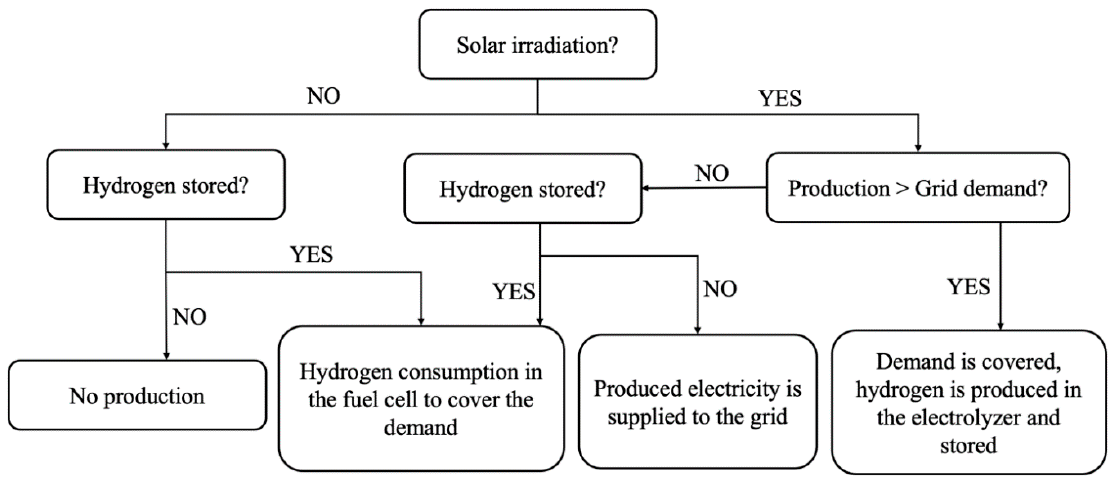
Figure 4. Operational and dispatch flow-chart of the ISCC power plant layout with hydrogen generation system.